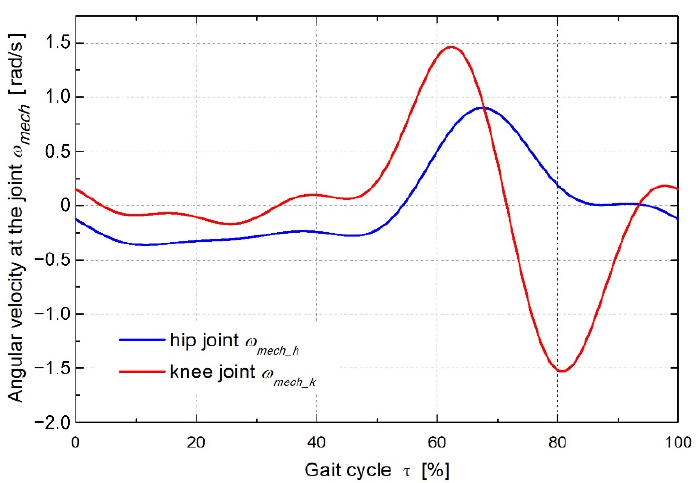
Figure 14. The required angular velocity runs at the driven joints for step length of l = 0.4 m.